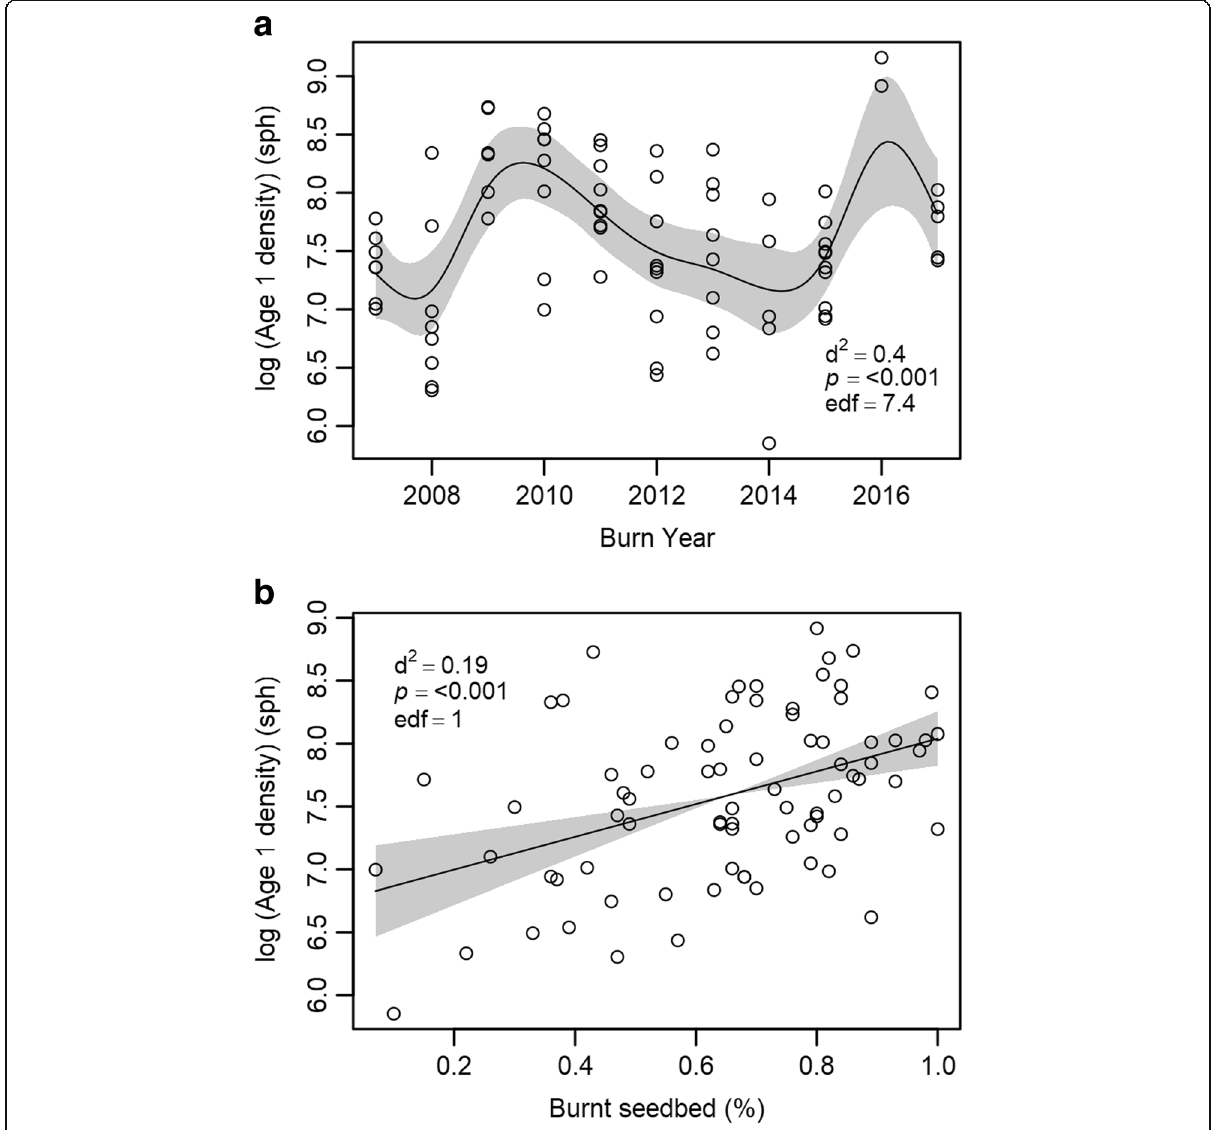
Fig. 7 Results of generalized additive models of the relationship between eucalypt density at age 1 year with a year burnt and b burnt seedbed in ARN coupes ( n = 76). Shaded areas indicate the 95% confidence interval. Density was log-transformed prior to modeling. d 2 is the proportion of the null deviance explained by the model. p values indicate the approximate significance of the single smooth term, while edf is the estimated degrees of freedom for the smooth